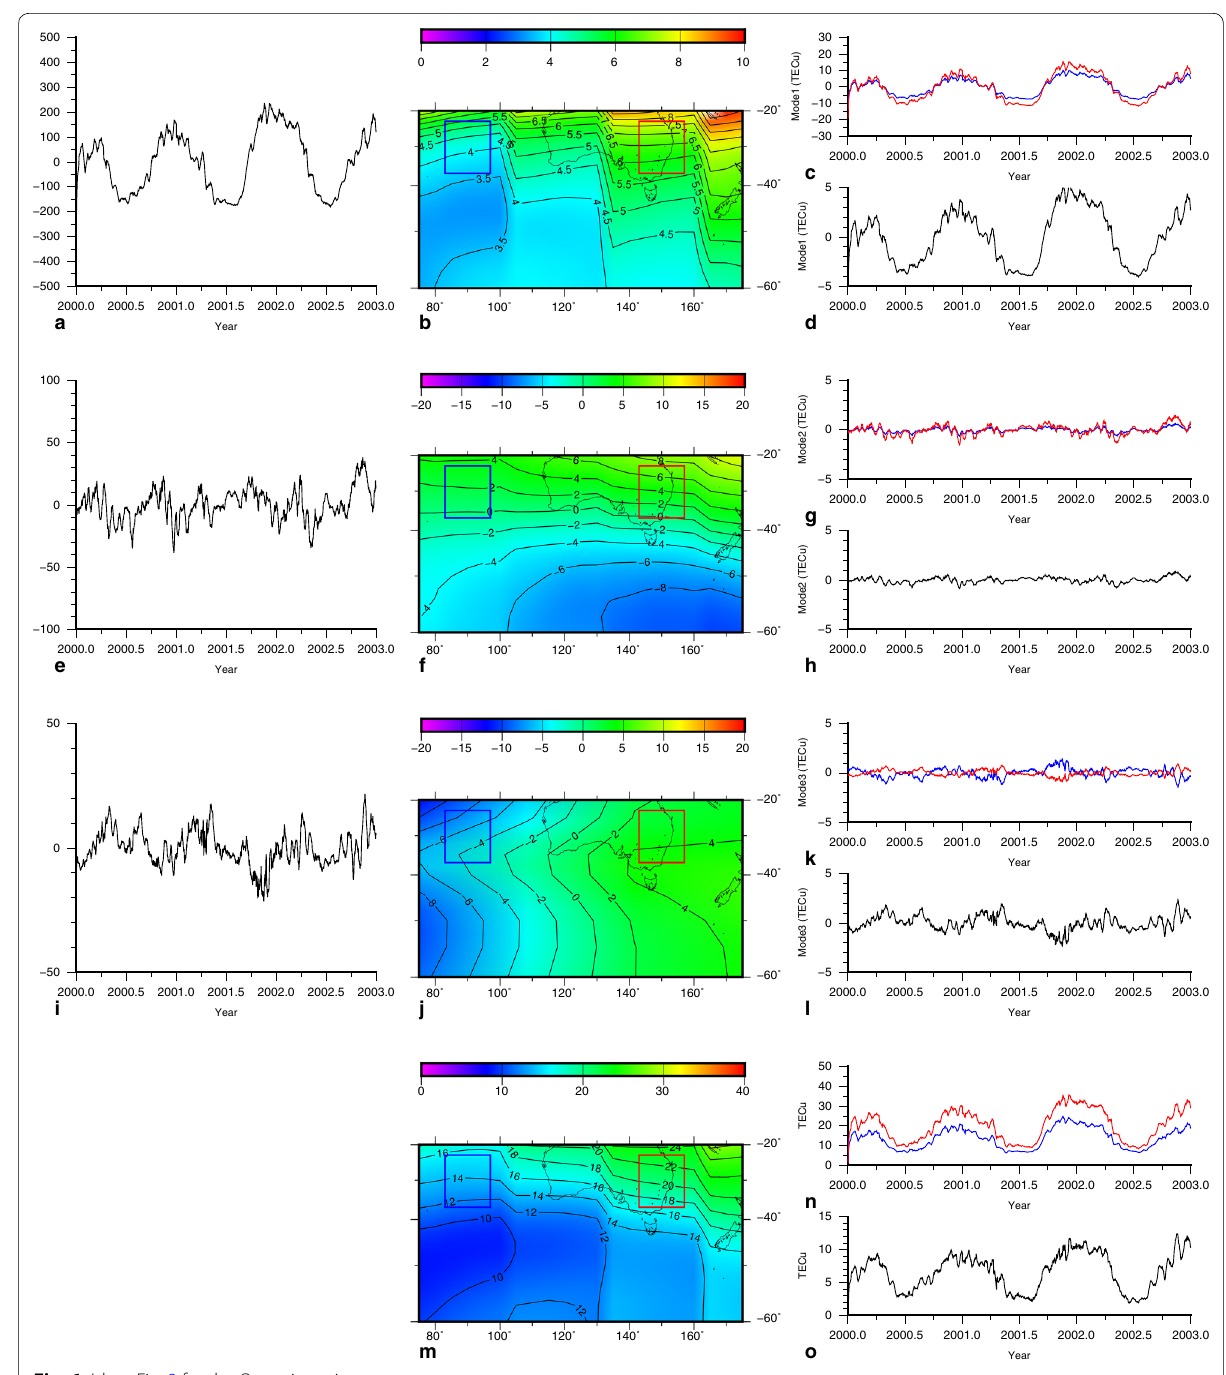
Fig. 6 Idem Fig. 3 for the Oceania